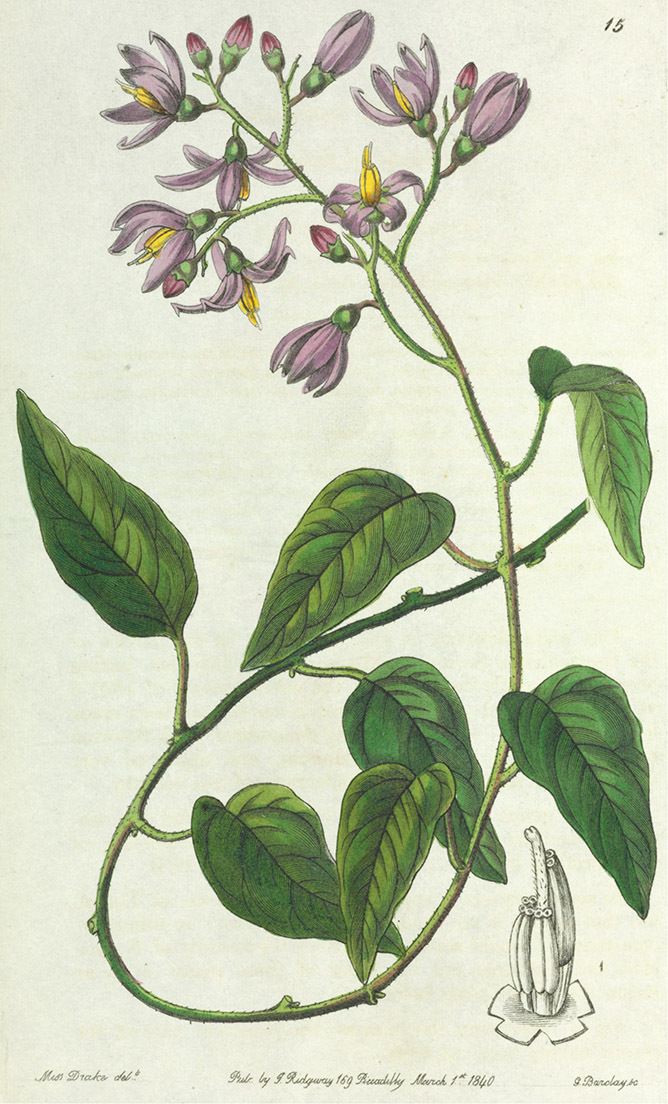
Plate accompanying the original description of Solanum uncinellum Lindl. clearly showing the unequal anthers and narrow petals typical for this species (Lindley 1840: tab. 15). Reproduced with permission of the Natural History Museum Botany Library.